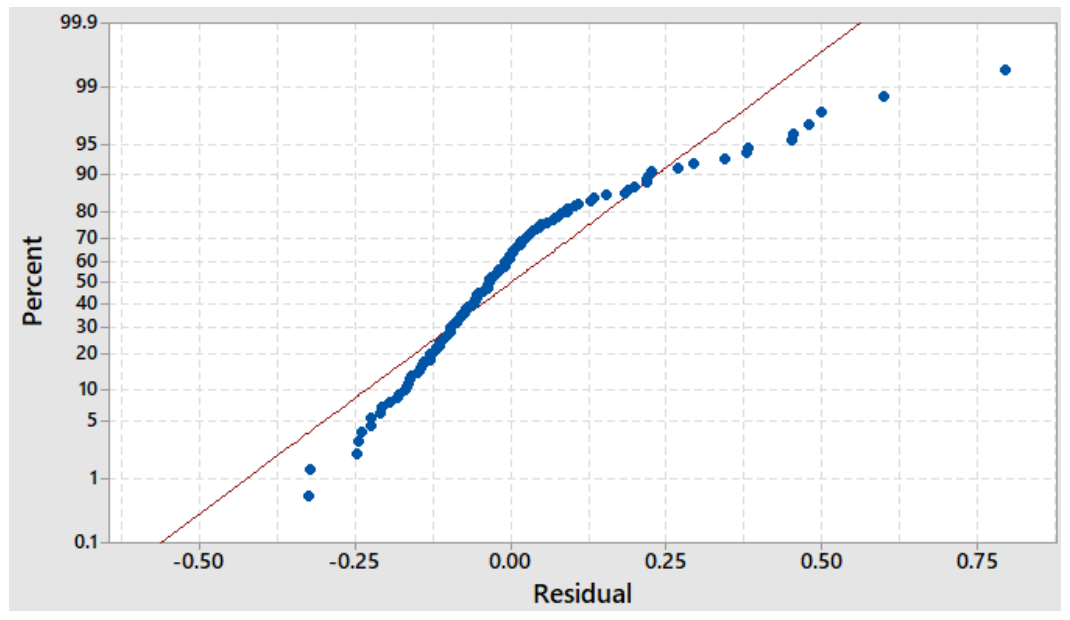
Figure 7. Normal probability plot—response in Ra (Taguchi case).